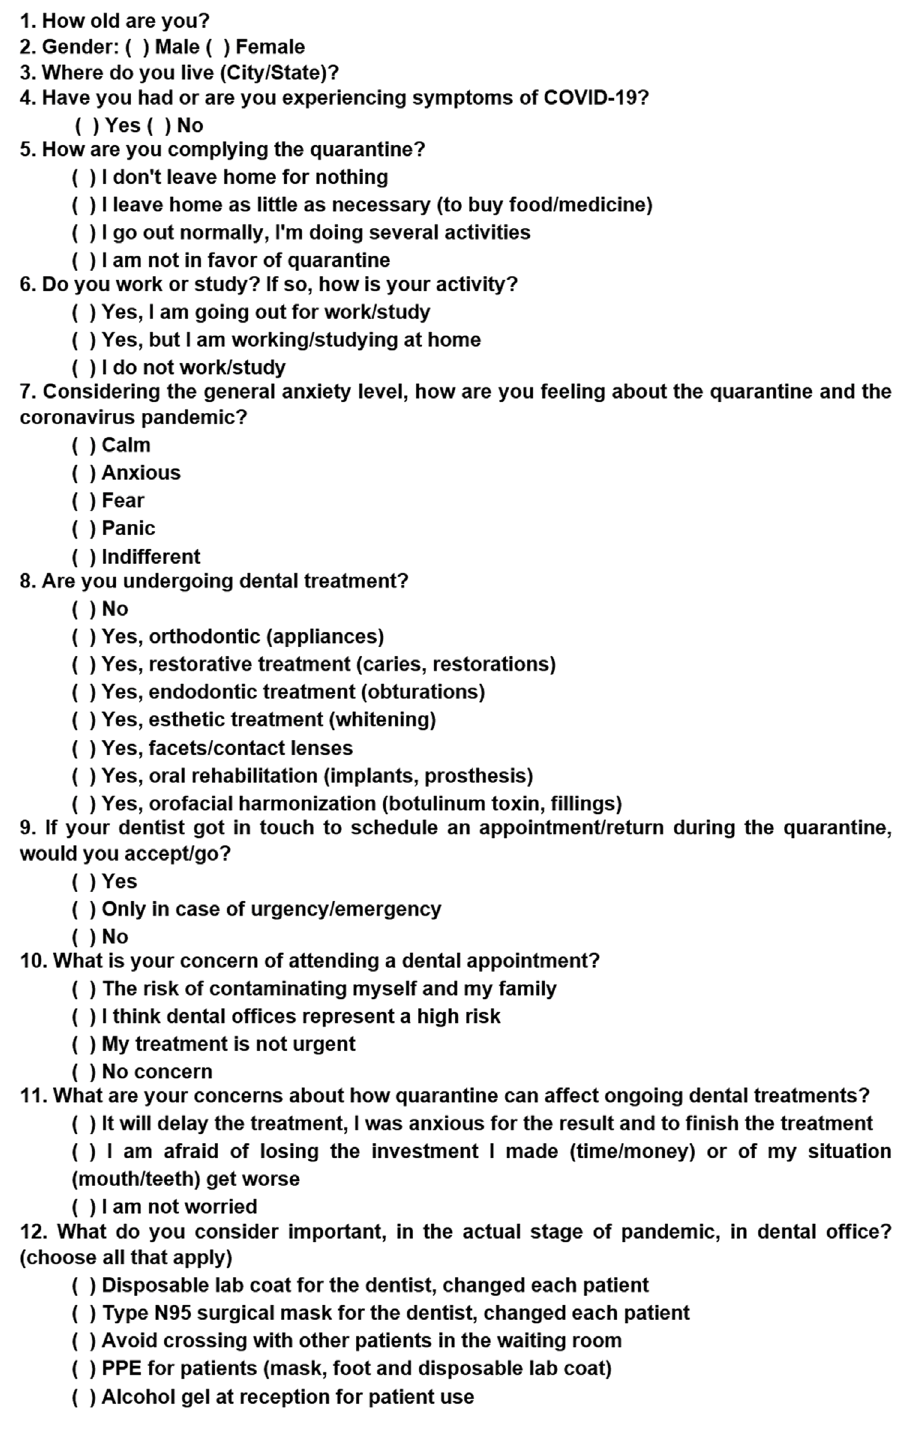
Figure 1. Questionnaire applied to the